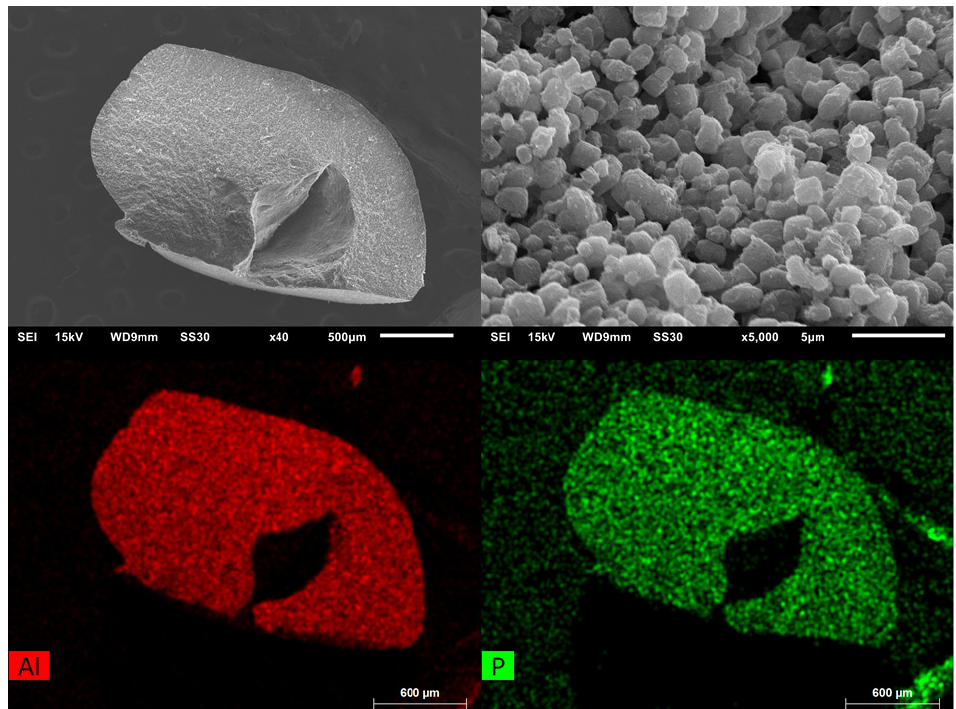
Figure 9. SEM images of MIL-160(90)@chitosan at different magnifications (left: overview; right: close-up). EDX-mapping measurement for aluminum and phosphorus (bottom). The dark features in the element maps, that is, the lower amounts of Al and P in the center and to the upper right of the bead are due to X-ray blocking by the groove in the bead surface so that the generated element-specific X-rays cannot be detected.